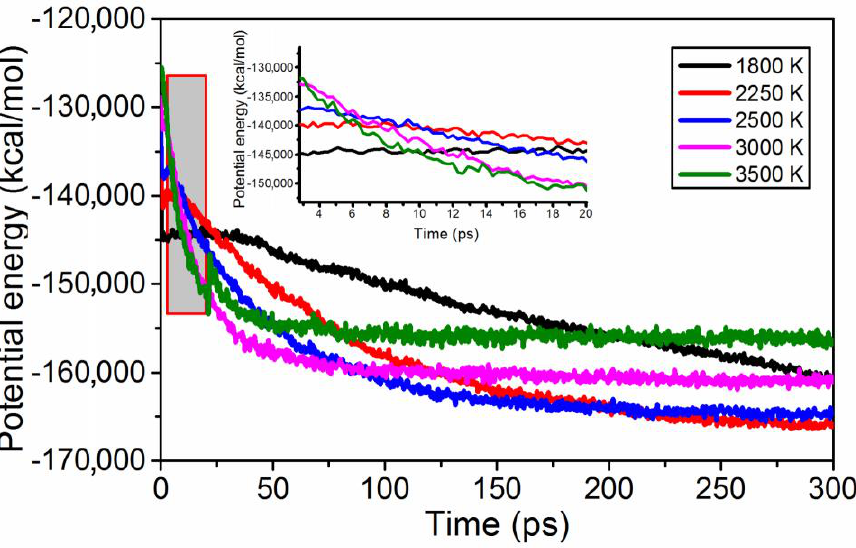
Figure 6. Evolution of the potential energy of the system over time at different temperatures.